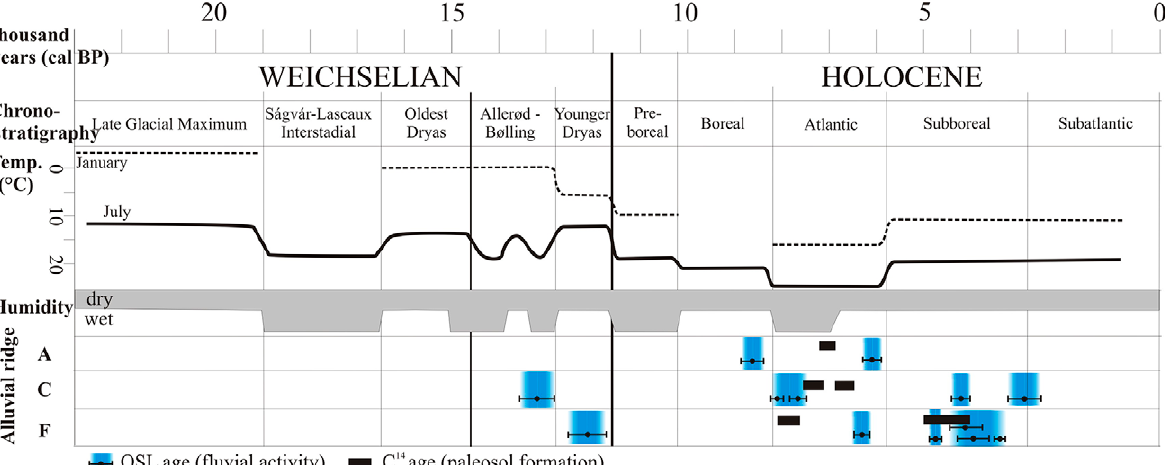
Figure 6. Formation of overbank deposits and paleosols compared to climate elements (source: Borsy et al., 1989; Gábris & Nádor, 2007, Hernesz & Kiss, 2013; Sümeghy et al., 2013; Kiss et al.,